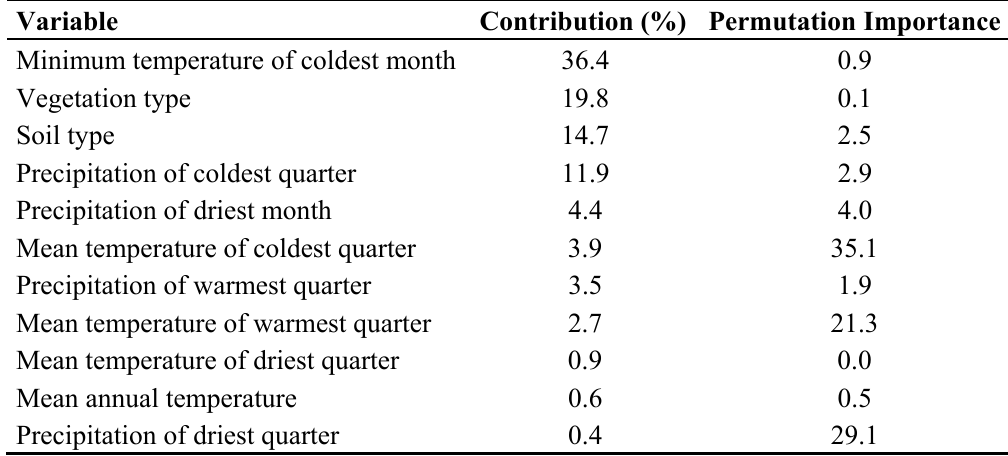
Table 2. Contribution of the variables to the potential distribution of Picea chihuahuana Martínez in Mexico at national